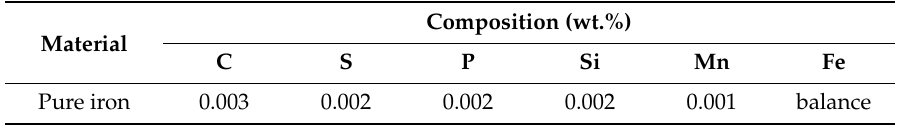
Table 1. Chemical composition of pure iron.